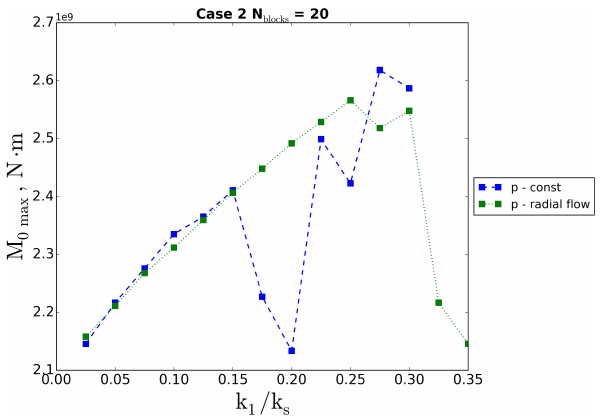
Figure 22. The block system cumulative seismic moment depen- dence on the stiffness of the interblock link.